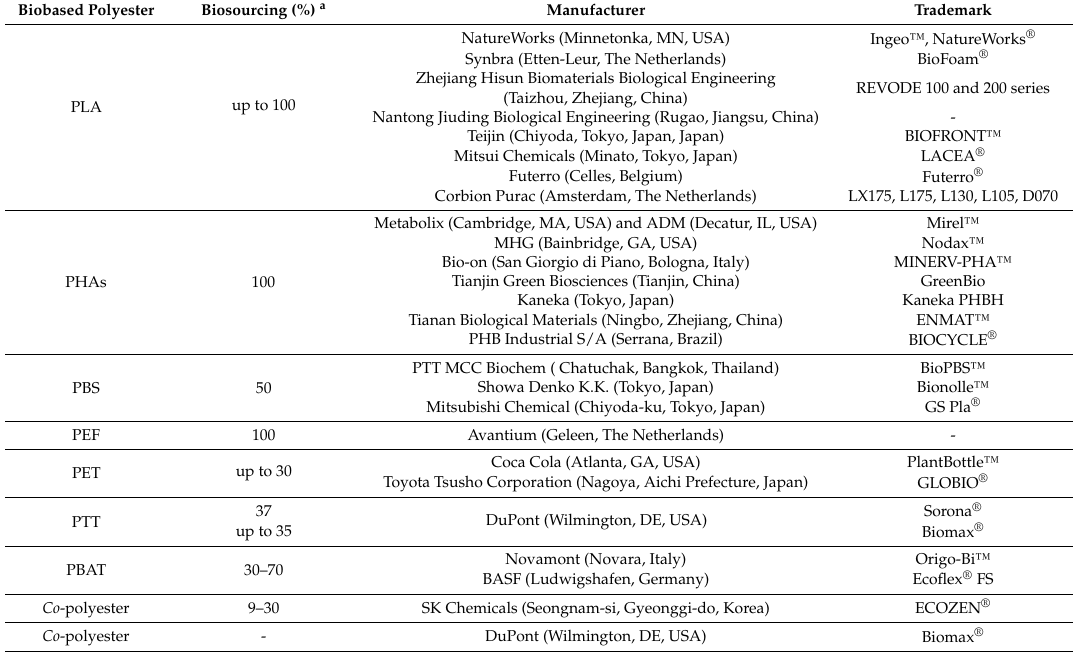
Table 1. A selected list of commercially available biobased polyesters and their manufacturers. Biobased